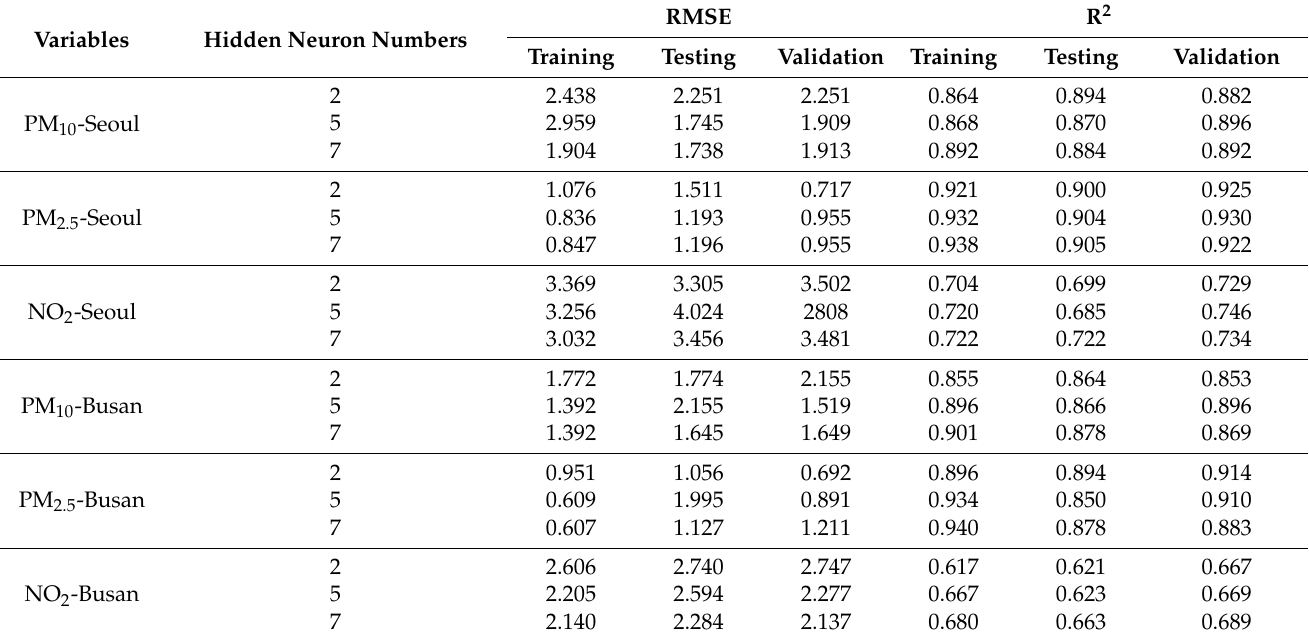
Table 4. Performance validation of the optimal ANN model with 2, 5, and 7 hidden layer nodes. showing RMSE and R 2